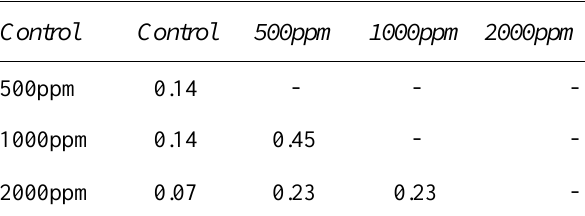
Table 1: Pairwise comparison of 16S profiles from high- Pb experiments samples. Similarities are described by Jaccard Similarity Coefficient